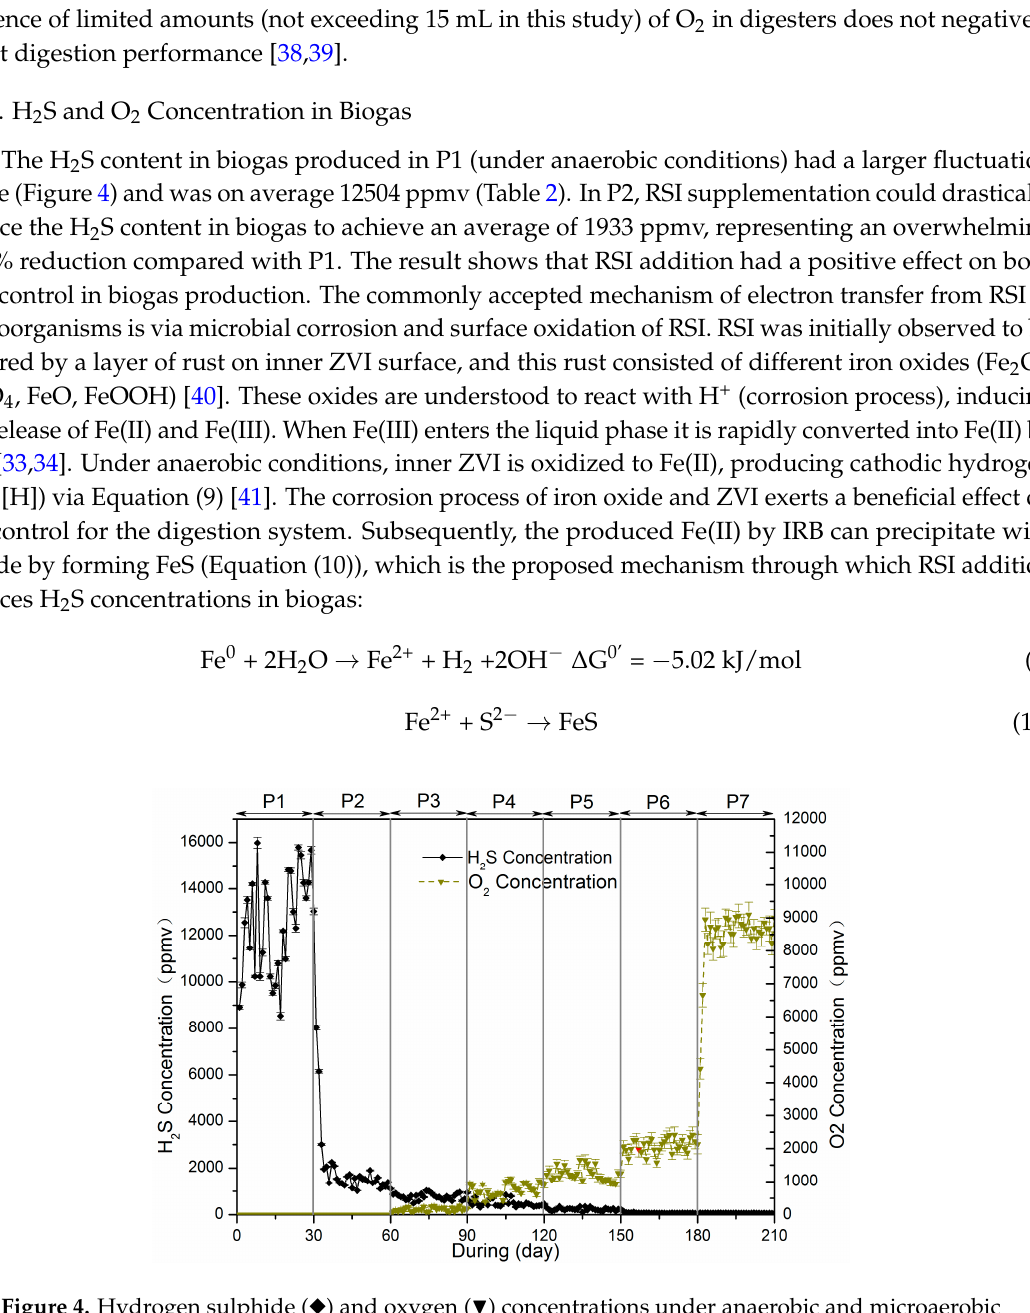
Figure 4. Hydrogen sulphide ( ◆ ) and oxygen ( ▼ ) concentrations under anaerobic and microaerobic conditions during semi-continuous digestion of activated sludge supplemented with RSI (error bars represent standard deviation, n = 3).